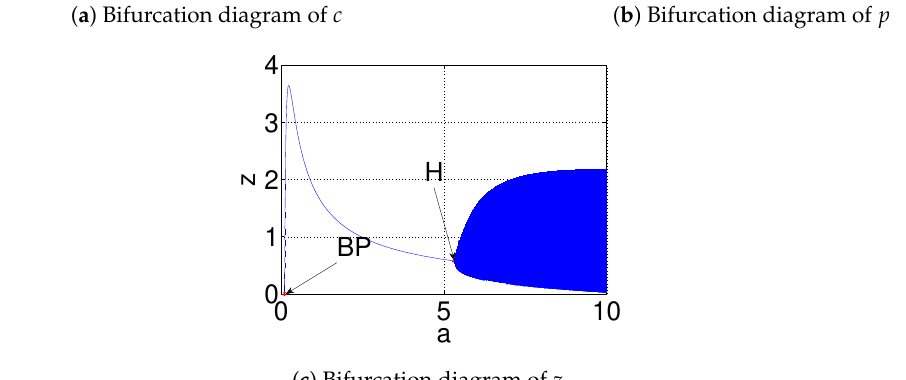
Figure 17. Bifurcation diagrams of system (1) taking a as the bifurcation parameter, while the others remain unchanged, as in Figure 6. Here, the zooplankton free equilibrium E 1 ( (cid:101) c , (cid:101) p ,0 ) is stable when 0 < a < a [ tc ] = 0.109643, and the interior equilibrium (cid:98) E ( (cid:98) c , (cid:98) p , (cid:98) z ) is stable when a ∈ ( 0.109643, a [ H ] = 5.325675 ) and unstable with periodic solution when a > a [ H ] = 5.325675.